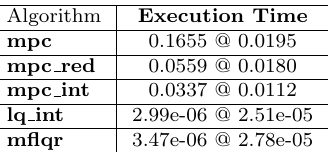
Table 3: The table shows the mean execution time for mpc , mpc red , mpc int , lq int and mflqr algorithms for each time step. Mean @ Stan- dard